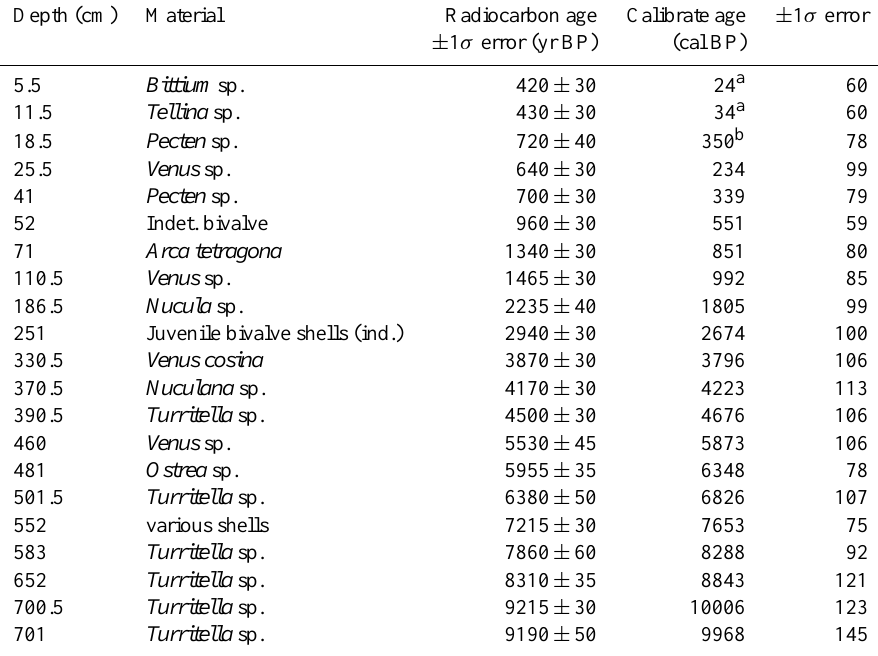
Table 1. AMS radiocarbon dated levels and their calibrated ages with a 1 σ uncertainty for the KSGC-31 gravity core. The analyses were performed at the Laboratoire de Mesure du Carbone 14, Saclay (France) and at the Beta Analytic Radiocarbon Dating Laboratory (Florida; USA). Raw radiocarbon ages were corrected and calibrated to calendar ages using the Calib7.1 software (Stuiver and Reimer, 1993) and the MARINE13 calibration data set (Reimer et al.,